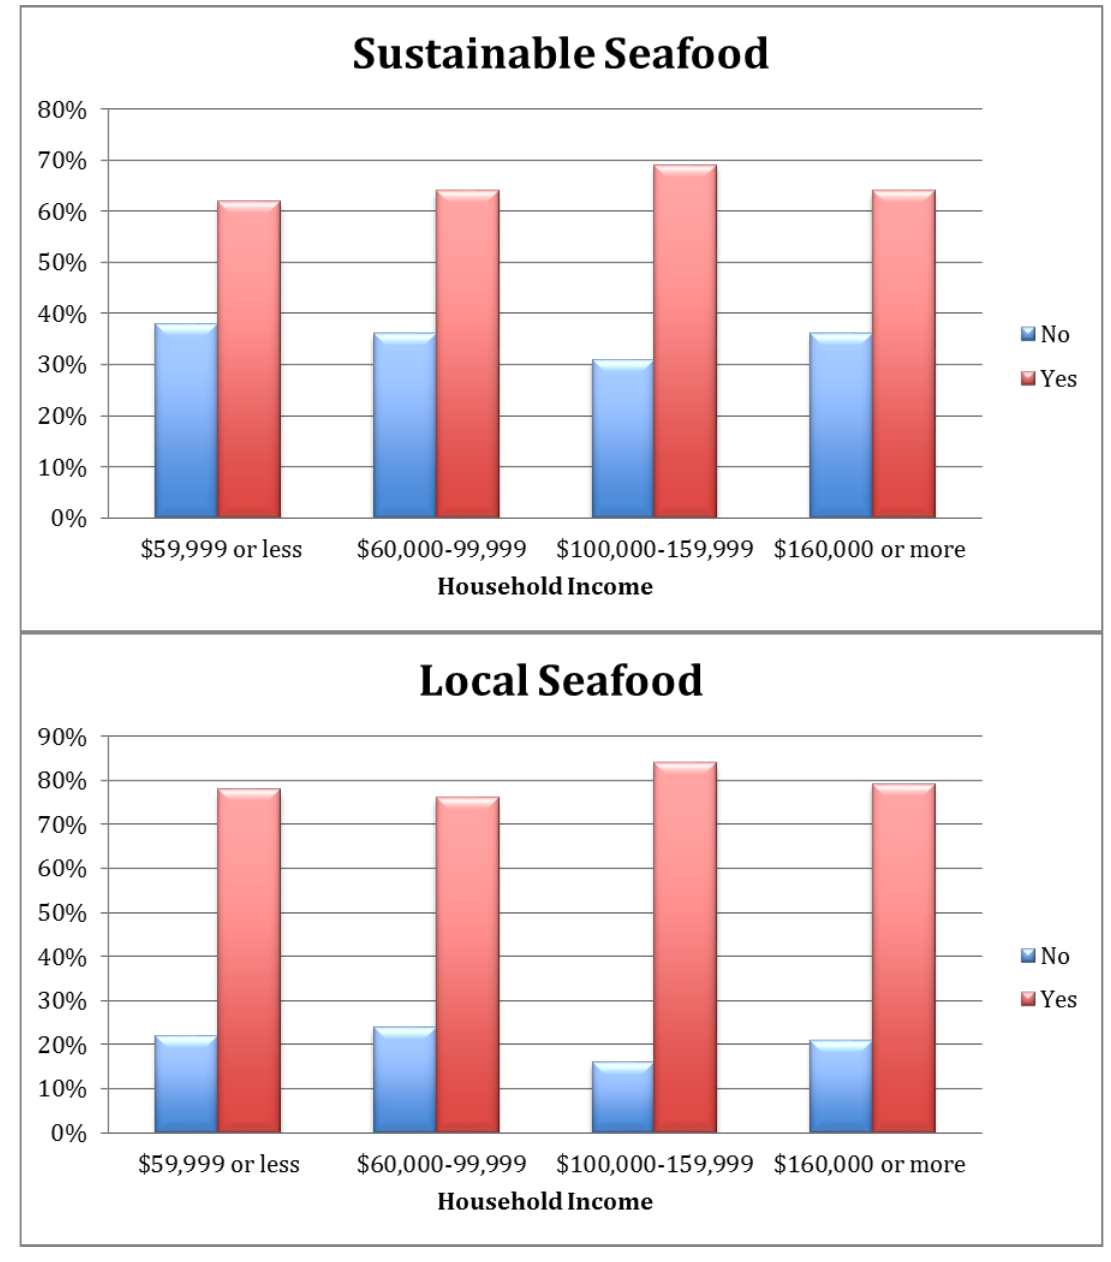
Figure 7. Willingness to pay a seafood premium, based on household income. The local seafood premium, a lesser amount, was explained as an addition to the sustainable seafood